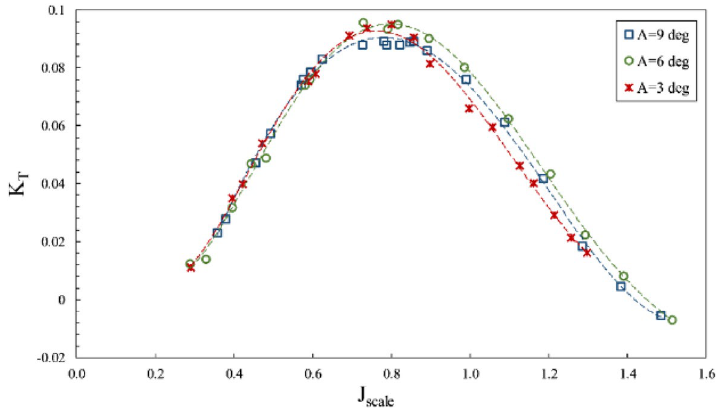
Figure 20. Thrust coefficient on propeller direction in different inclination angles ( I = 0.4 ).